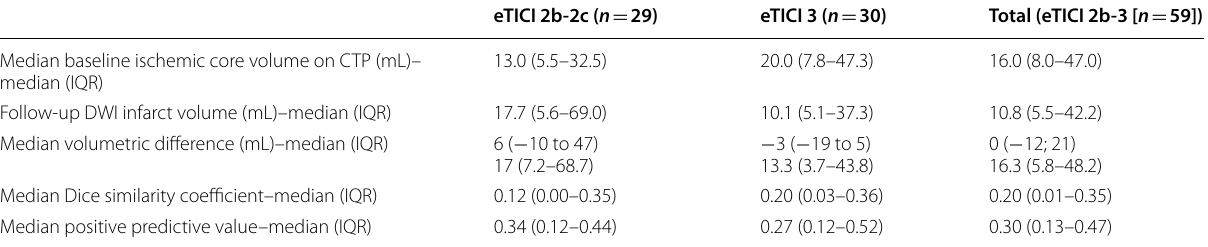
Table 2 Volumetric and spatial accuracy between baseline CTP ischemic lesions and follow-up DWI lesions for patients with eTICI 2b-2c vs. eTICI